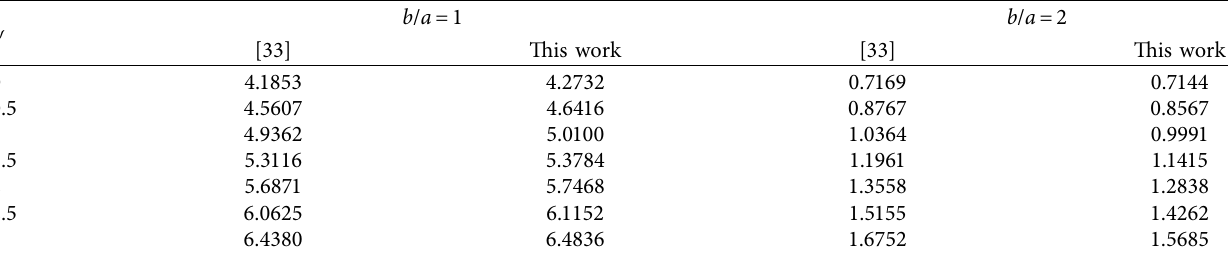
Table 3: Nondimensional deflection of fully simply supported homologous nanoplate subjected to uniformly distributed load. b / a � 1 b / a � ψ